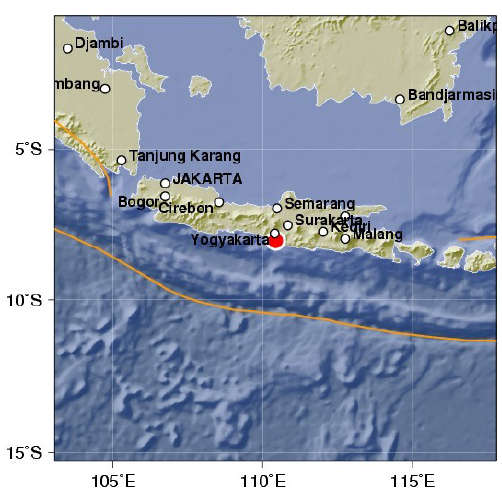
Fig. 5. Map of Java with earthquake localized near Yogyakarta. Source: GEOFON/GFZ